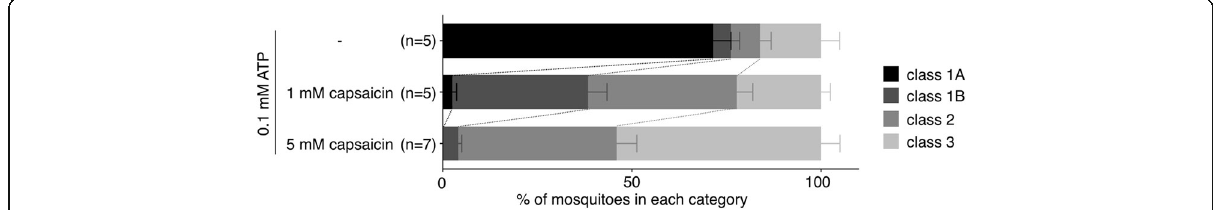
Fig. 5 Aversive action of capsaicin on feeding behavior of mosquitoes. Thirty to forty Ae. aegypti female mosquitoes that sucked 0.1 mM ATP solution containing 1 mM or 5 mM capsaicin were classified into four classes as shown in Fig. 4a: class 1A (black), class 1B (gray), class 2 (light gray), class 3 (gray-white). All experiments were performed more than five times. Chi-square test was performed